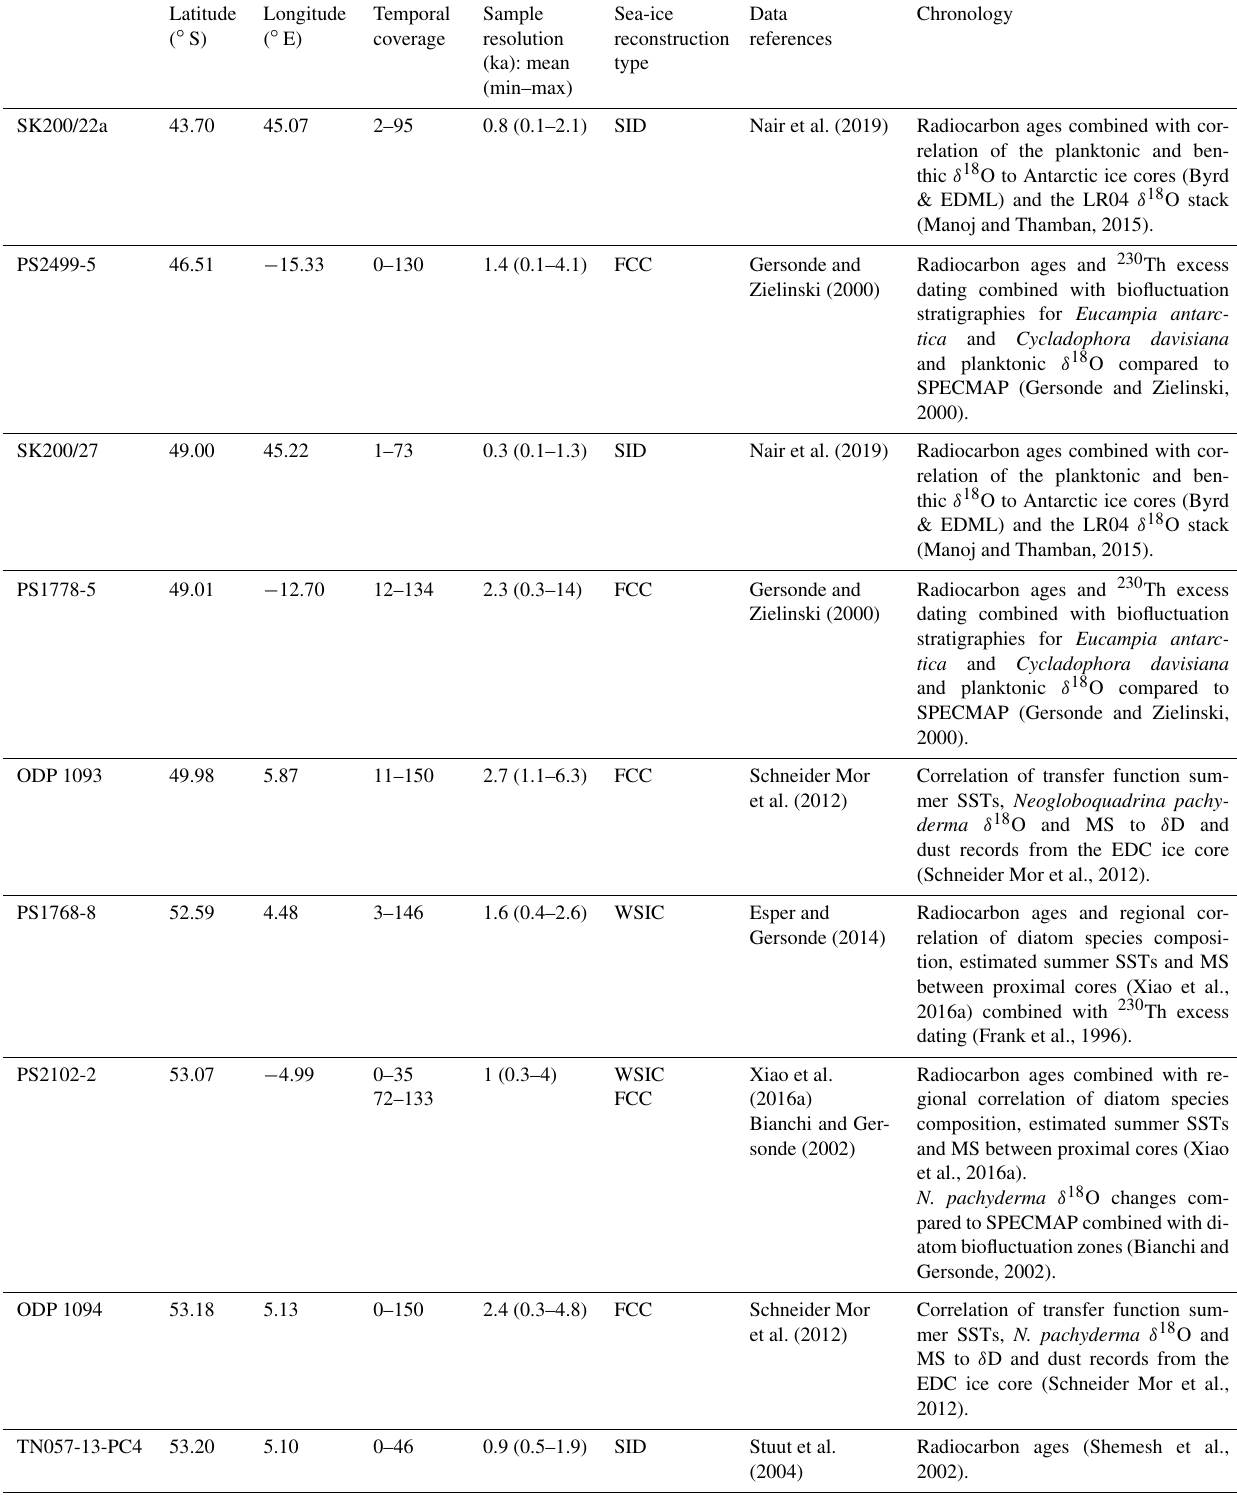
Table 1. Details for the 24 sediment cores and 1 Antarctic ice core which have sea-ice proxy records presented in this study, including location, temporal coverage and sample resolution of the data, what form the reconstructed sea-ice data comes in and references for both the data and chronology for each record. Cores are ordered by latitude from north to south. FCC: combined relative abundance of the diatom species Fragilariopsis curta and F. cylindrus , MS: magnetic susceptibility, Na ss : sea-salt sodium, SID: sea-ice duration, SST: sea-surface temperature, WSIC: winter sea-ice